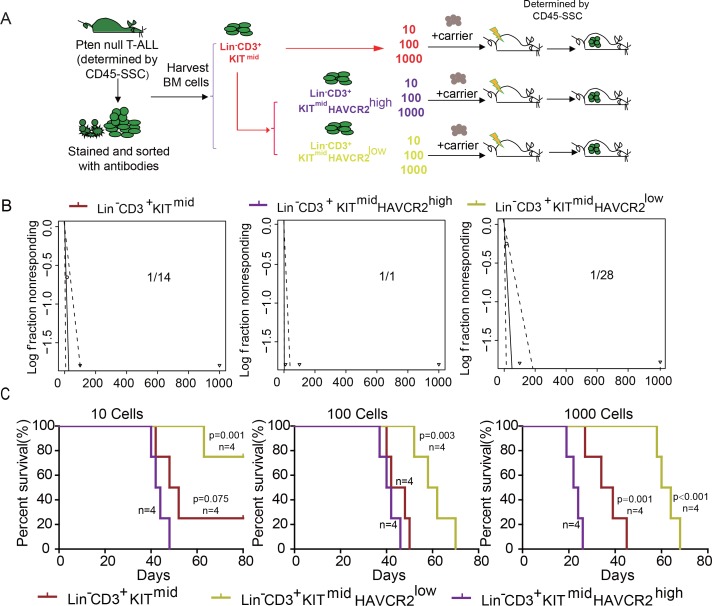
The HAVCR2high subgroup contains the vast majority of LSC activity.(A) Schematic illustrating the cell isolation, limiting dilution and transplantation procedures used for testing LSC activity as described in Guo et al. (Guo et al., 2008); (B) LSC frequencies were calculated for each subgroup according to Hu et al. (Hu and Smyth, 2009);(C) Survival curves showing LSC activity in each of the sorted subgroups upon transplantation (n = 4). Student’s t-test was used to calculate the p-value.